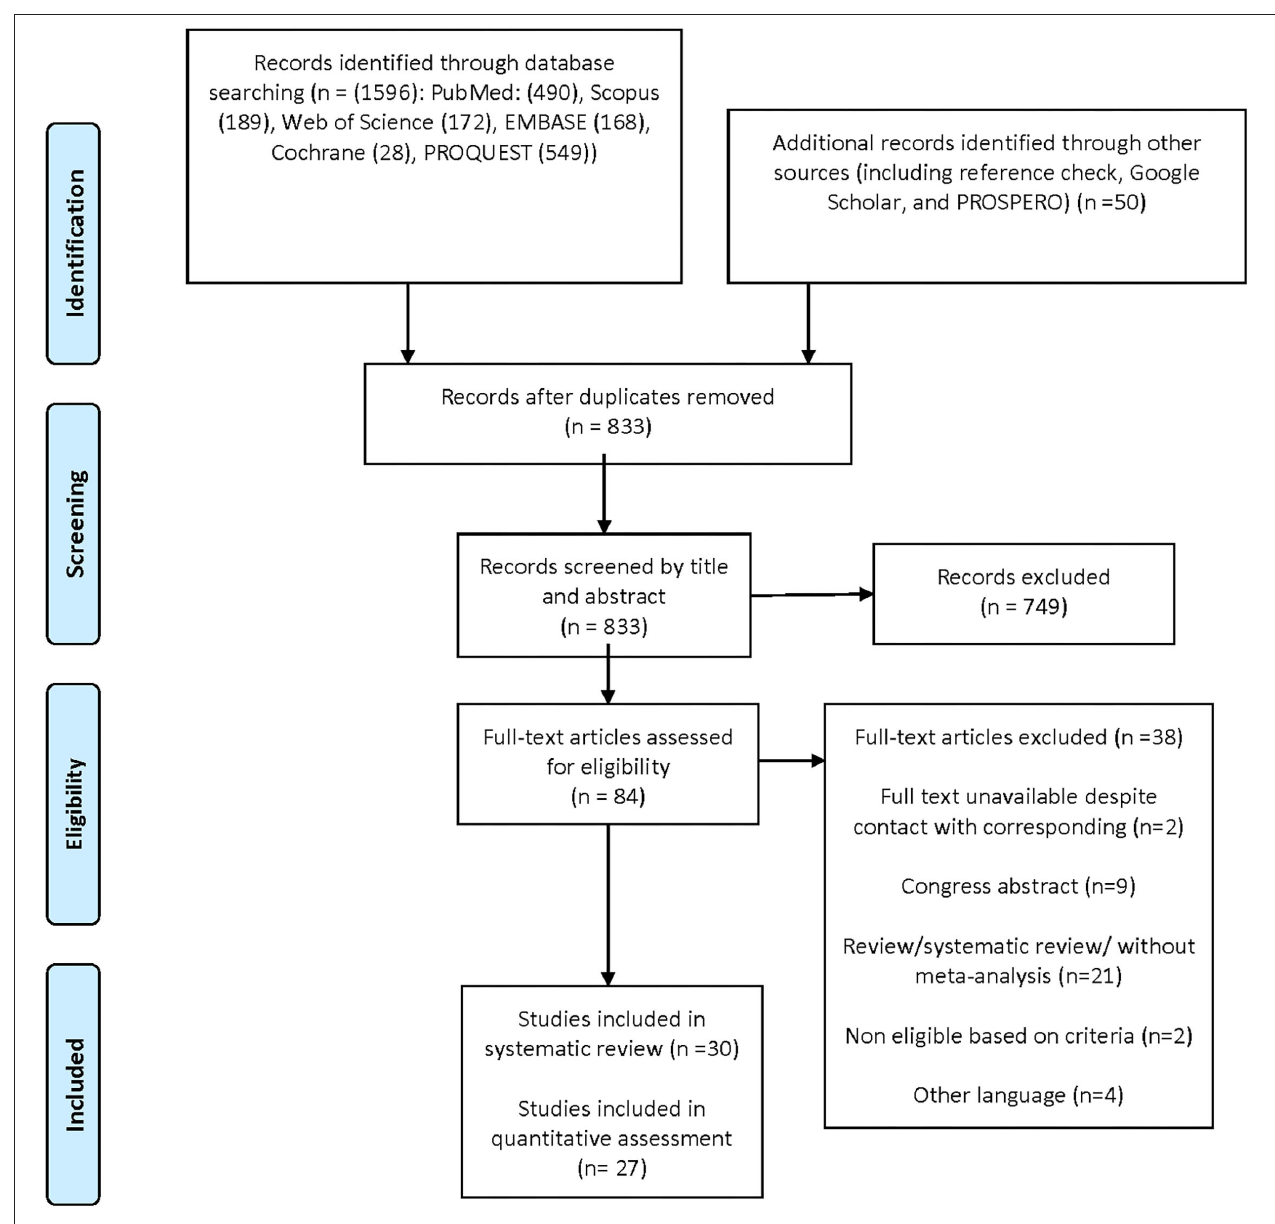
FIGURE 1 | The flowchart of the literature searchaccording to PRISMA.